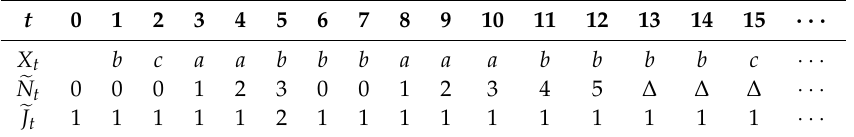
Table 1. Sample paths of (cid:101) N t and (cid:101) J t corresponding to the sample path of X t , bcaababbaaabbbbc · · · . t